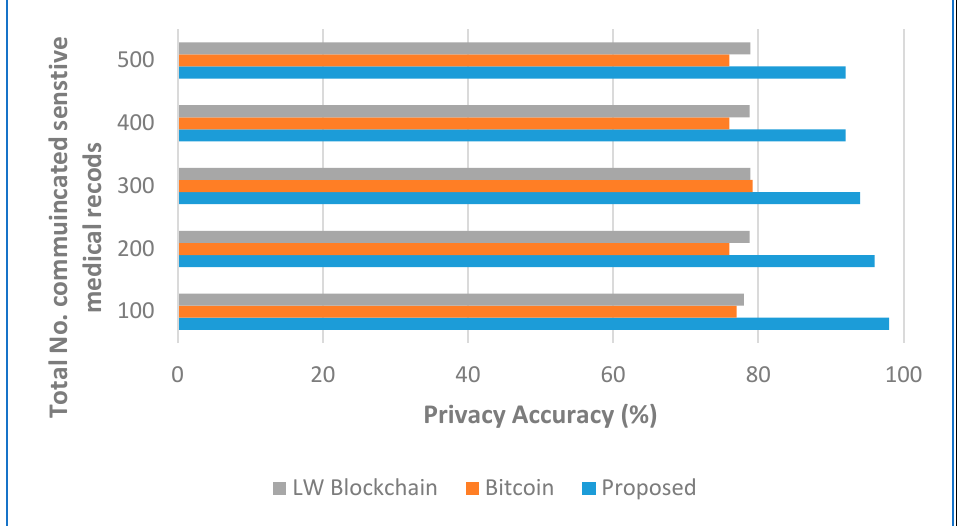
Figure 8. Security accuracy analysis when the number of medical records increases.